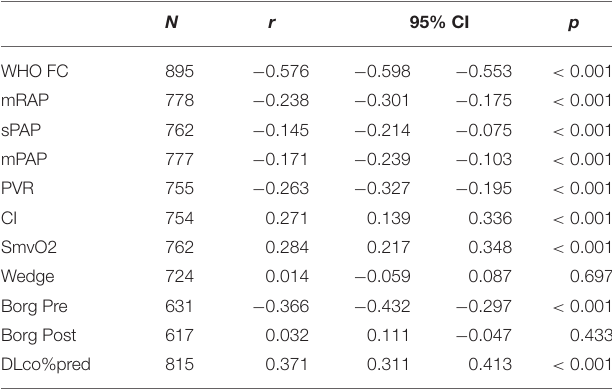
TABLE 2 | Correlation of ISWD%pred with WHO FC, hemodynamics, dyspnea score and